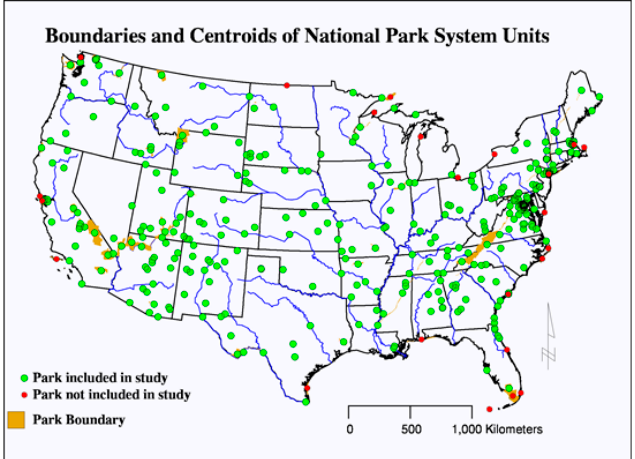
Figure 2. Map showing boundaries and centroids of national parks in the conterminous United States that were (and were not) included in this study.